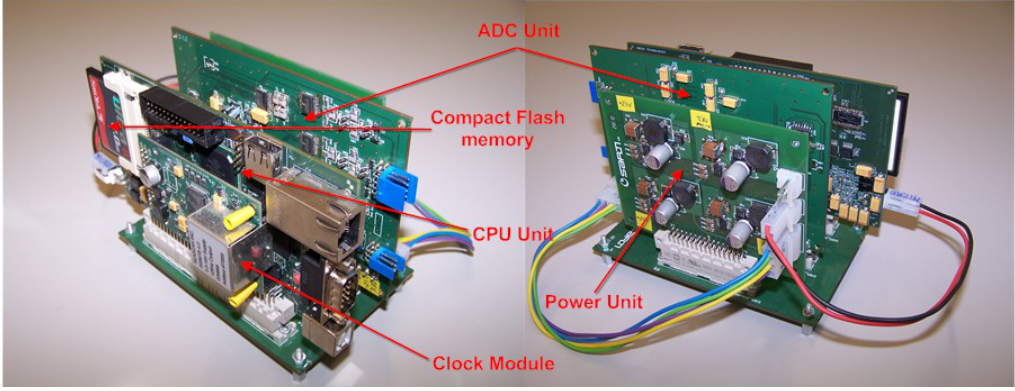
Figure 16. Packaging of the OBS electronic